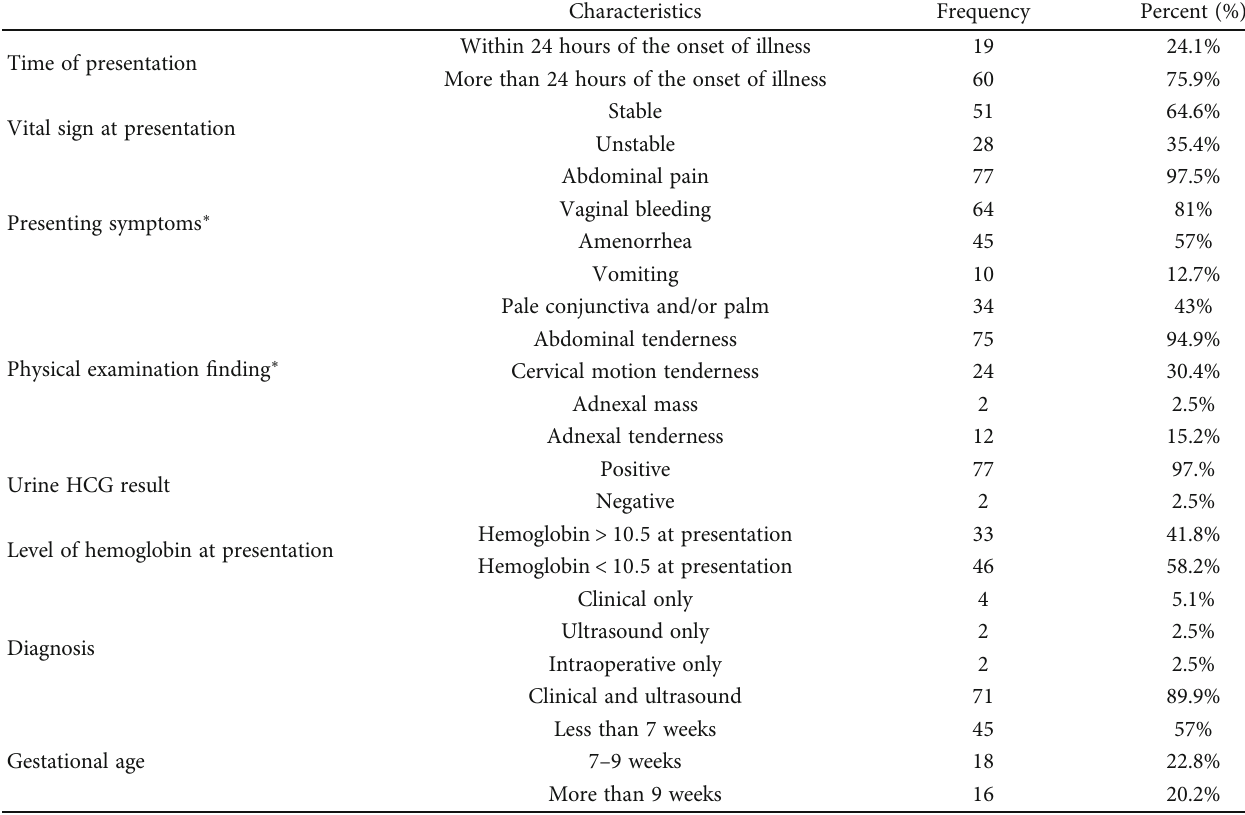
Table 2: Clinical presentation of patients of women admitted with ectopic pregnancy in Aksum (AKU CHS CSH and Saint Marries General Hospital) in Tigray, North Ethiopia, ( n = 79 ).